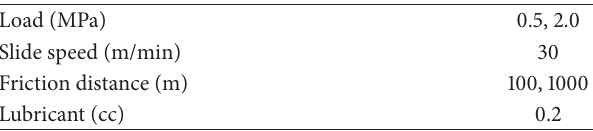
Table 1: Parameters of friction experiment.